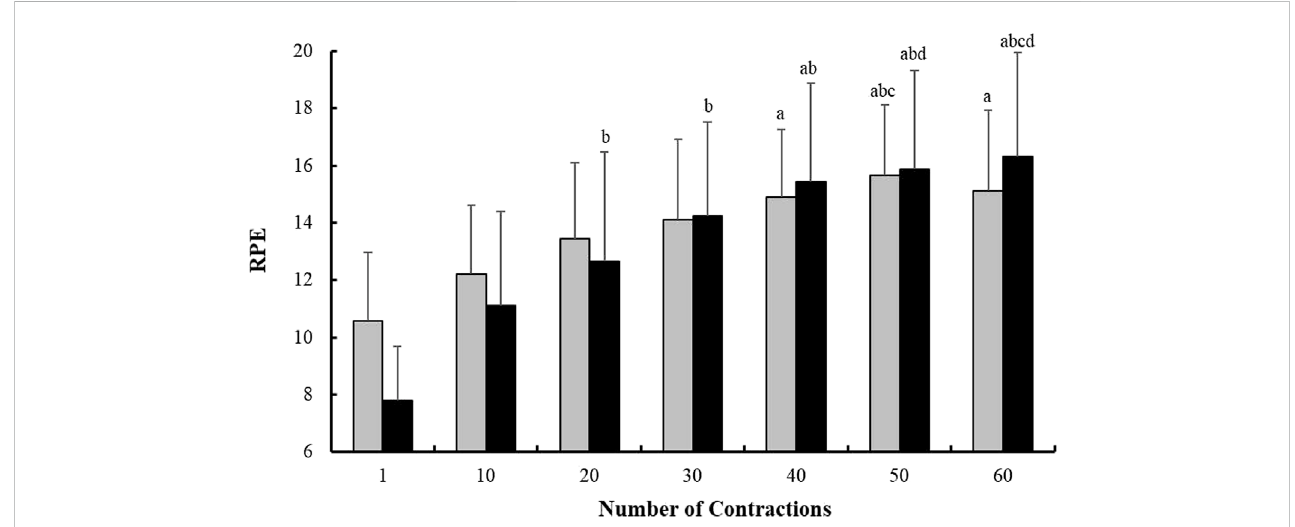
FIGURE 1 Evolution of the Rate of Perceived Exhaustion (RPE) response measured every 10 isometric Maximal Voluntary Contraction (iMVC) during the fatiguing taskforeachcondition(Pre-cooling:whitebars,andControl:blackbars).a p < 0.05 vs .iMVC1;b p < 0.05 vs .iMVC10;c p < 0.05 vs .iMVC20;andd p < 0.05 vs . iMVC